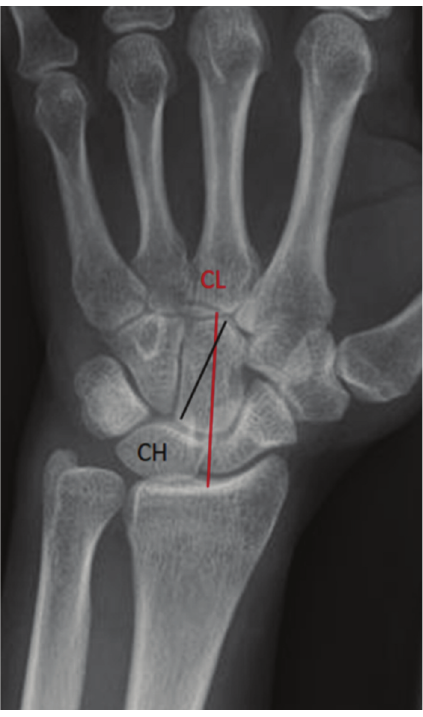
CL is the carpal height and CH is the capitates length. Fig. 2: Revised carpal height ratio (RCH ratio) = CL/CH.